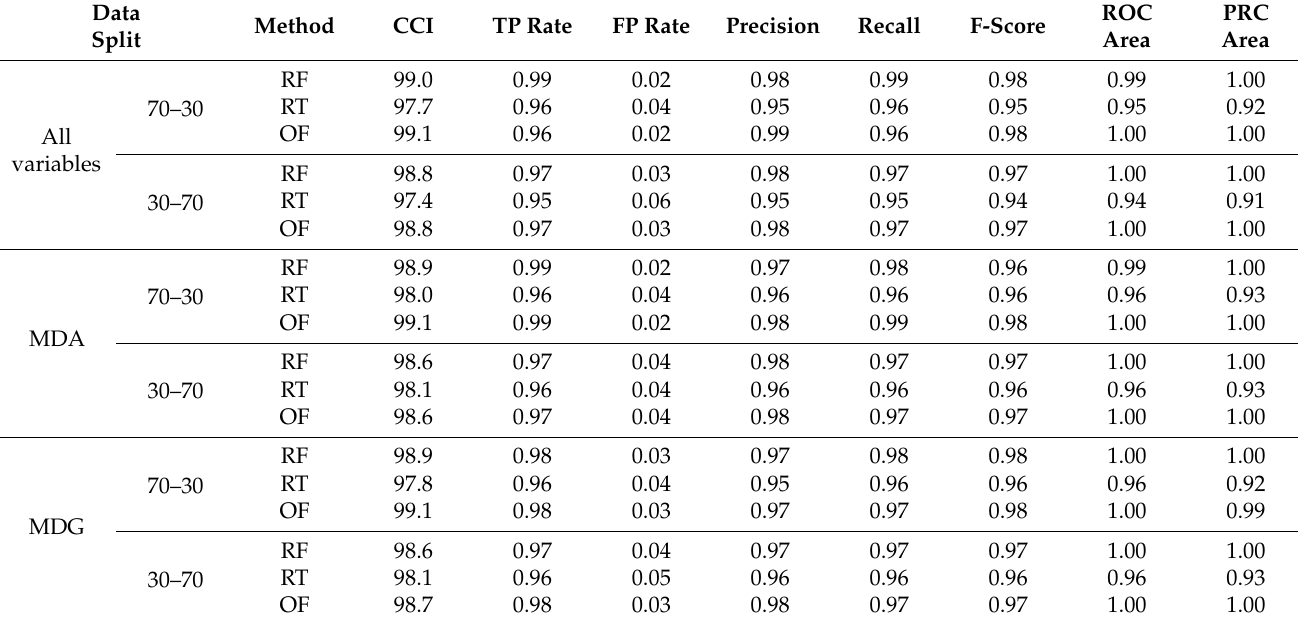
Table 2. Accuracy assessment results of the building classification.